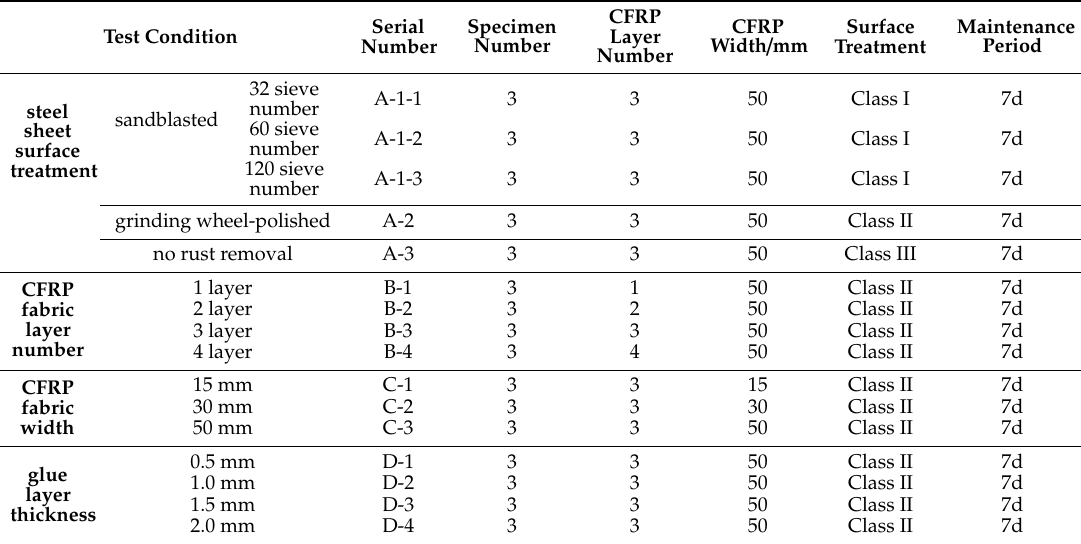
Table 2. Specimens’ details in each testing